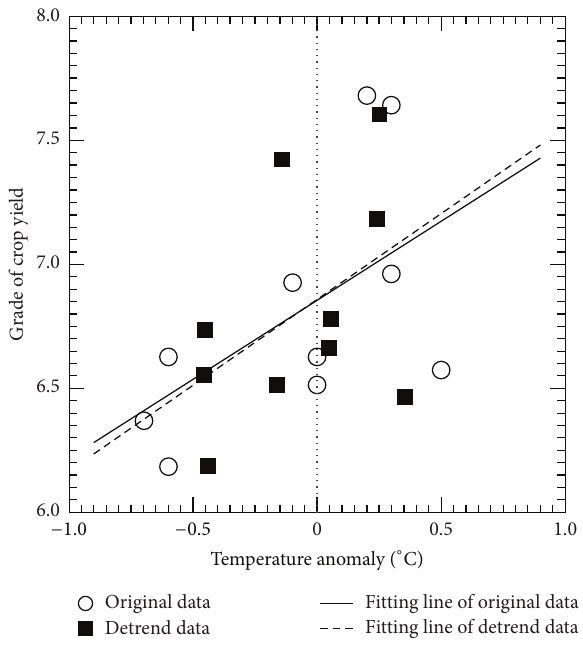
Figure 4: The correlation between crop yield and